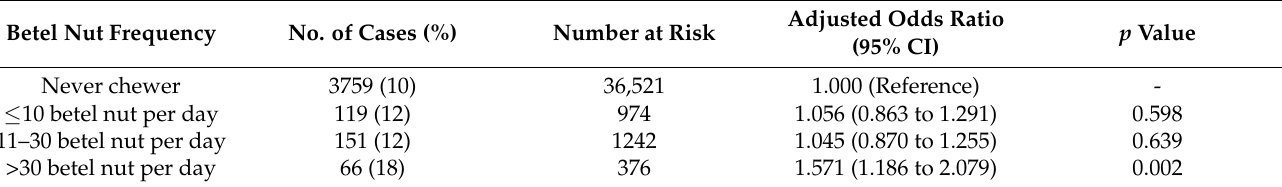
Abbreviations: as Table 1 and CI: confidence interval. Adjusting for age, smoking status, alcohol status, physical activity, marital status, educational status, body mass index, SBP, DBP, history of hypertension, history of dyslipidemia, history of diabetes mellitus, history of gout, platelet count, HbA1c, serum fasting glucose, total cholesterol, TG, LDL, HDL, serum albumin, creatinine, and